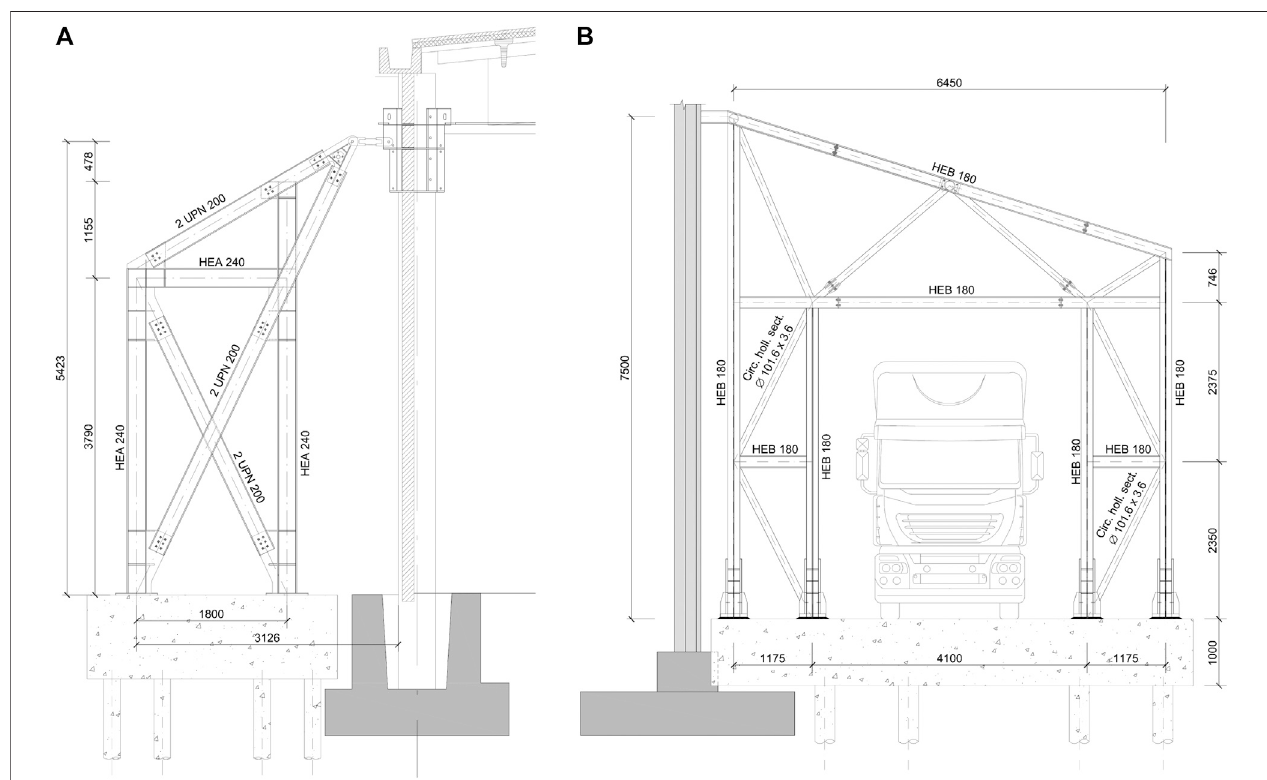
FIGURE 7 | Steel bracing systems applied to the outside of single-storey precast RC buildings: (A) single braced frame; (B) frame on laced built-up columns allowing for trucks circulation around the building. Dimensions in mm.